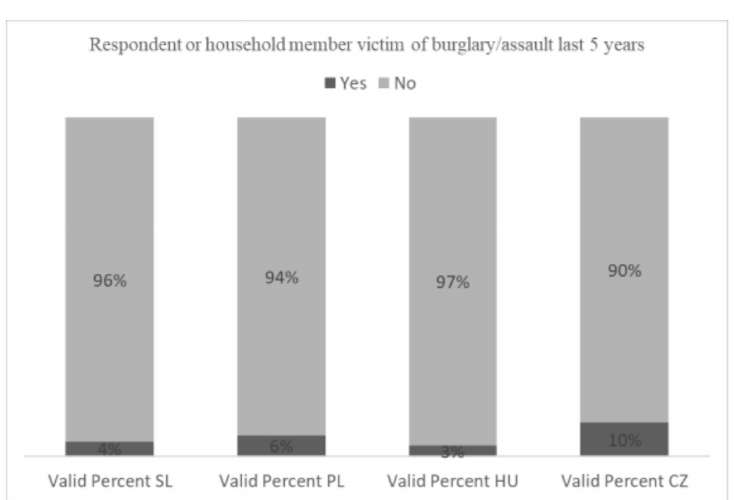
Figure 6. Responses regarding whether a household member has been a victim of a crime.